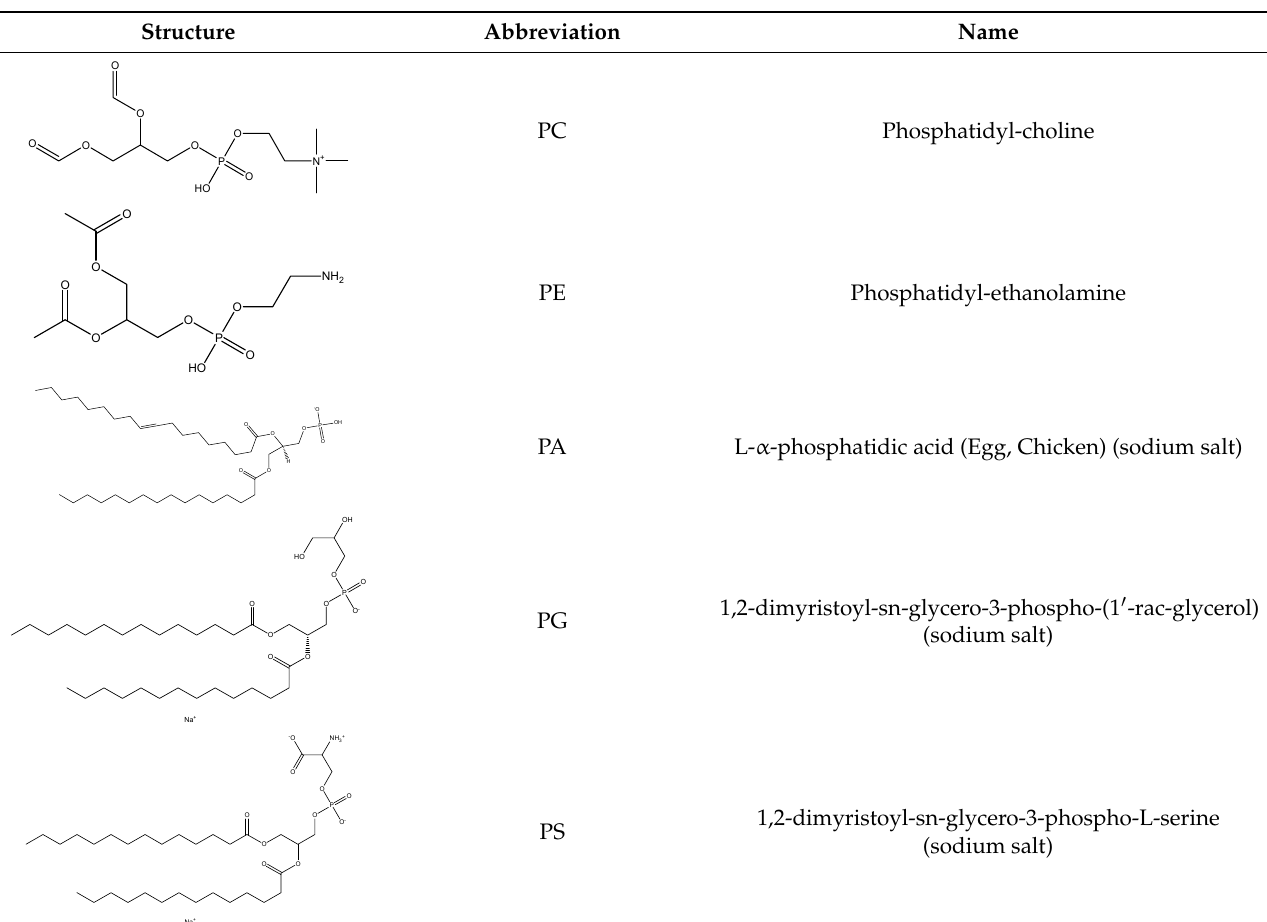
Table 6. Types of common anionic lipids used in formulating anionic liposomes. Structure